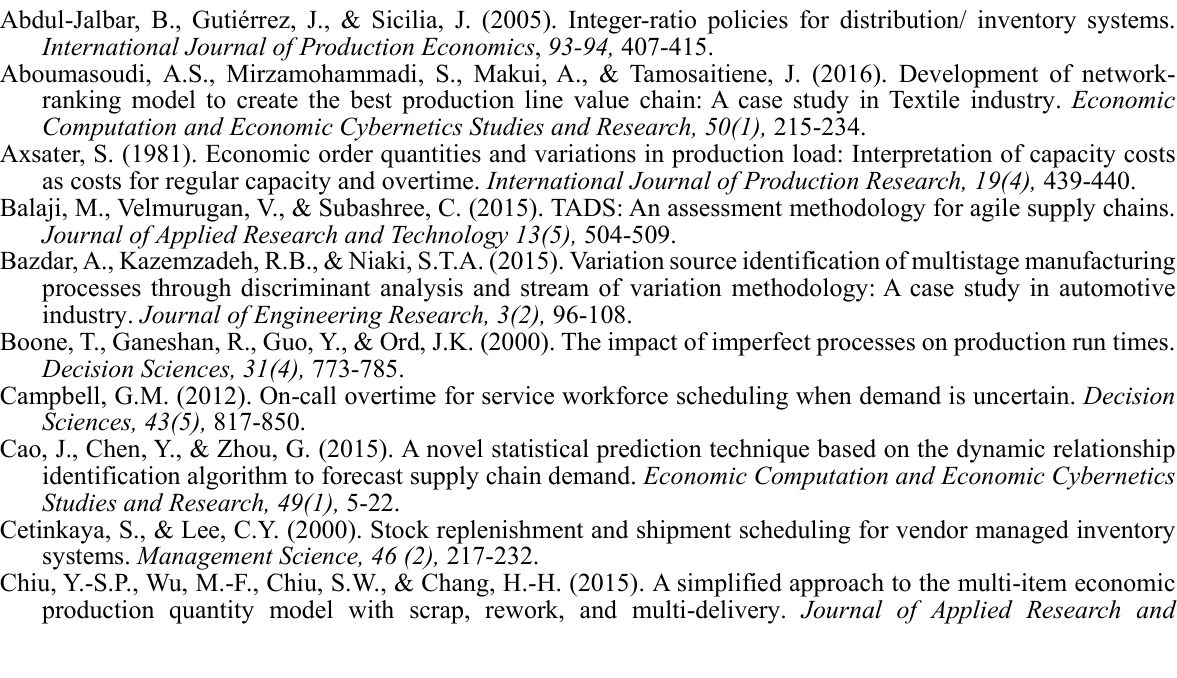
Fig. 10. Effect of overtime unit cost increase rate α 3 on the expected total system cost